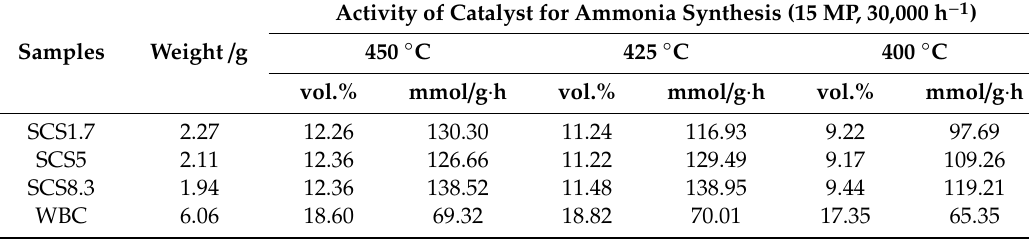
Figure 7. Reaction rate of ammonia synthesis over SCS catalysts with different glycine/Fe. Table 5. Activity of catalyst prepared by solution combustion.